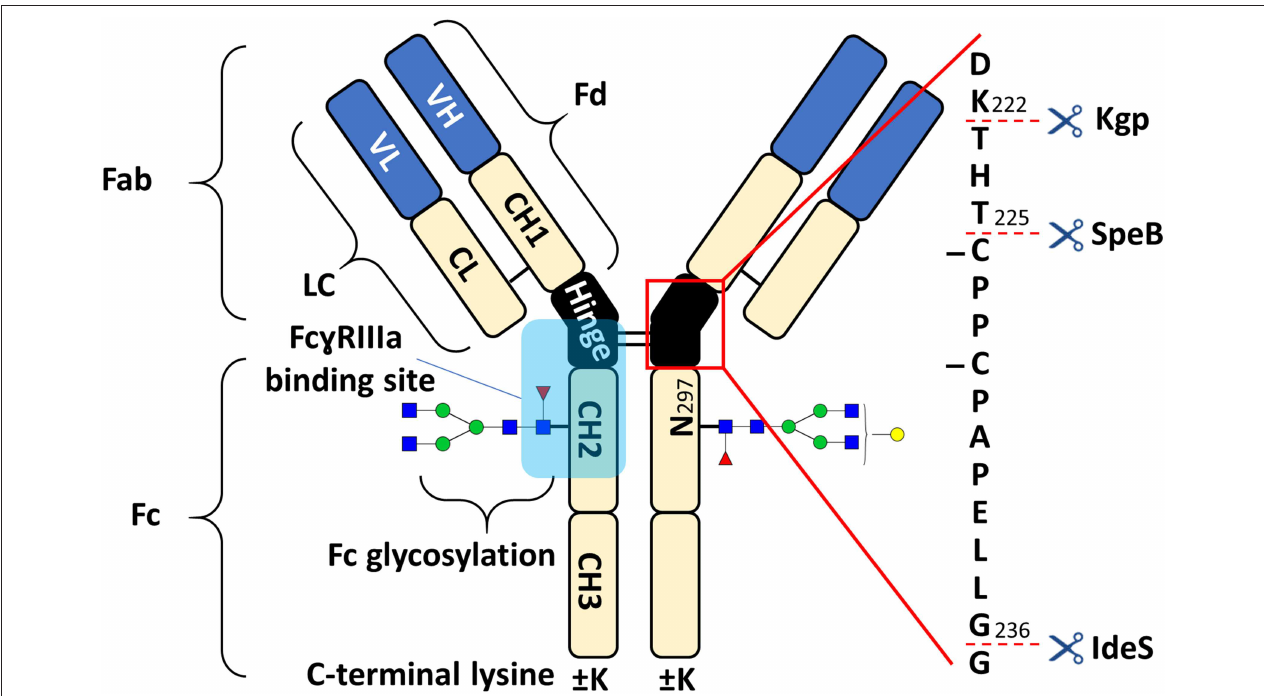
FIGURE 1 | Schematic overview of human IgG1 with a zoom into the hinge region, indicating cleavage sites of IdeS, SpeB, and Kgp. The heavy chain (HC) contains three constant domains (CH1–CH3) and a variable domain (VH), whereas the light chain (LC) has only one constant domain (CL) and a variable domain (VL). The Fd consists of VH and CH1. LC and Fd together form the antigen binding fragment (Fab). About 15% of plasma IgG contain one or more additional N -glycosylation sites in the variable domains (Anumula, 2012). CH2 and CH3 of the two heavy chains build the fragment crystallizable (Fc). Within the Fc is a conserved glycosylation site at N 297 in the CH2 (Jefferis, 2009). Between the CH1 and CH2 of the heavy chains is a mostly flexible hinge region and the four chains are covalently connected via disulfide bridges. Amino acids are presented with single letter code and numbered according to the Kabat system ( Kabat et al.,